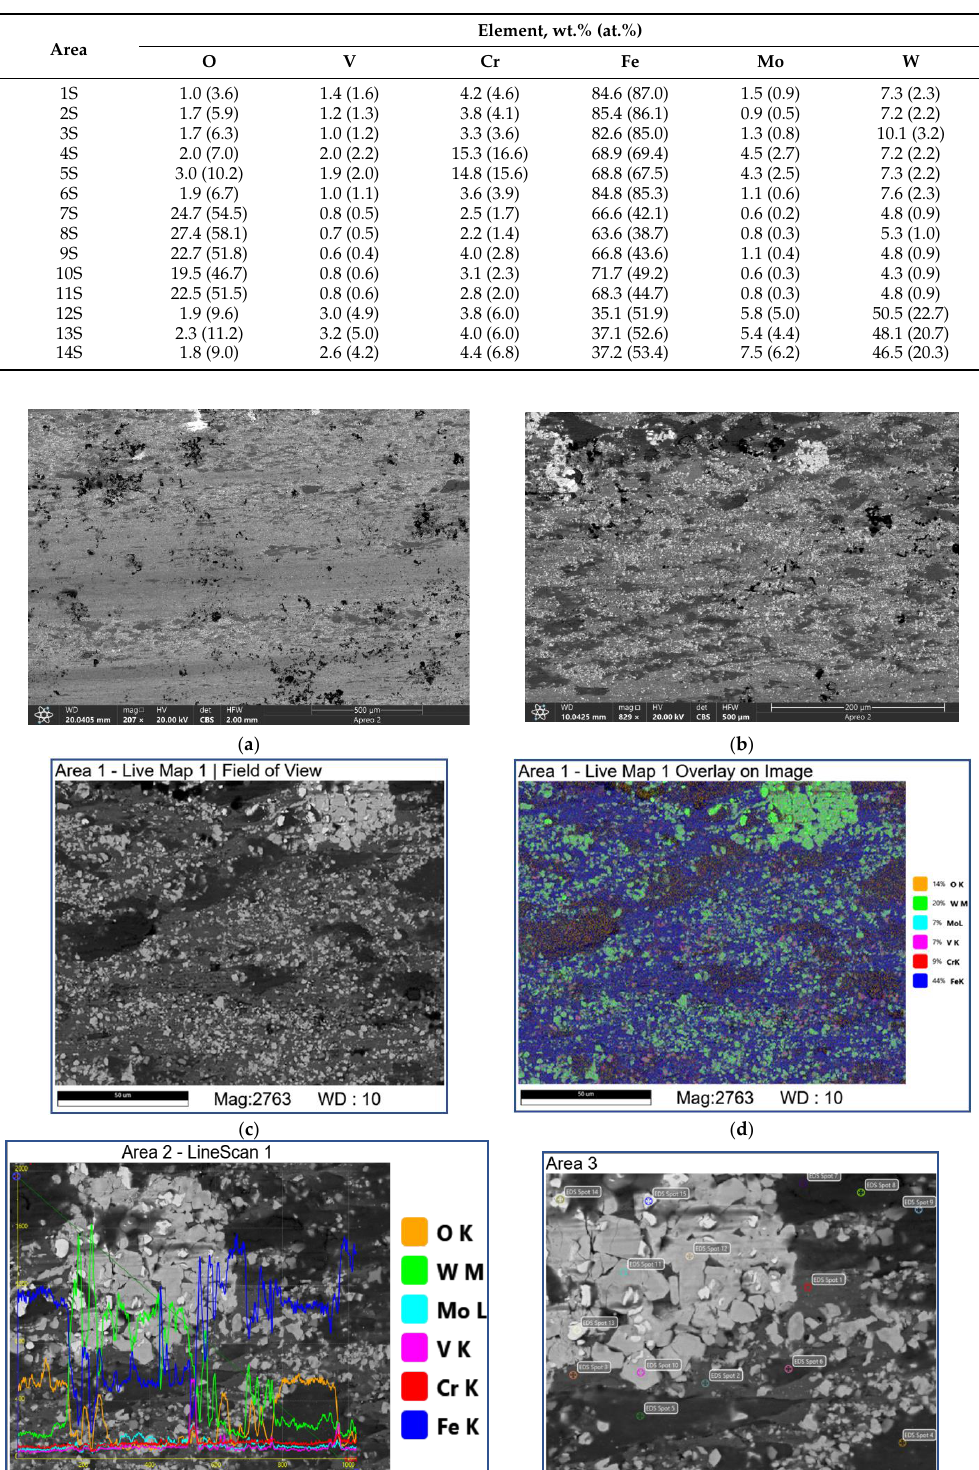
Table 3. EDS elemental composition of the M2/W worn surface on sliding at 1.2 m/s (Figure 10d).